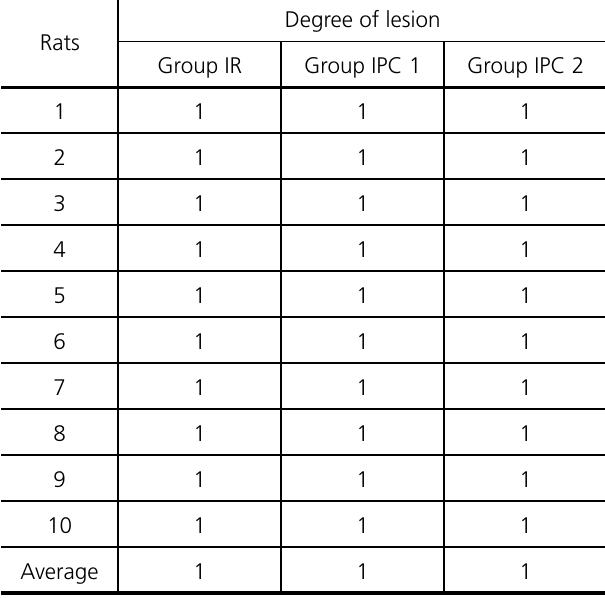
Table 1. Results of histological analysis of the reperfusion injury of lung according to Sizlan et al. [13]